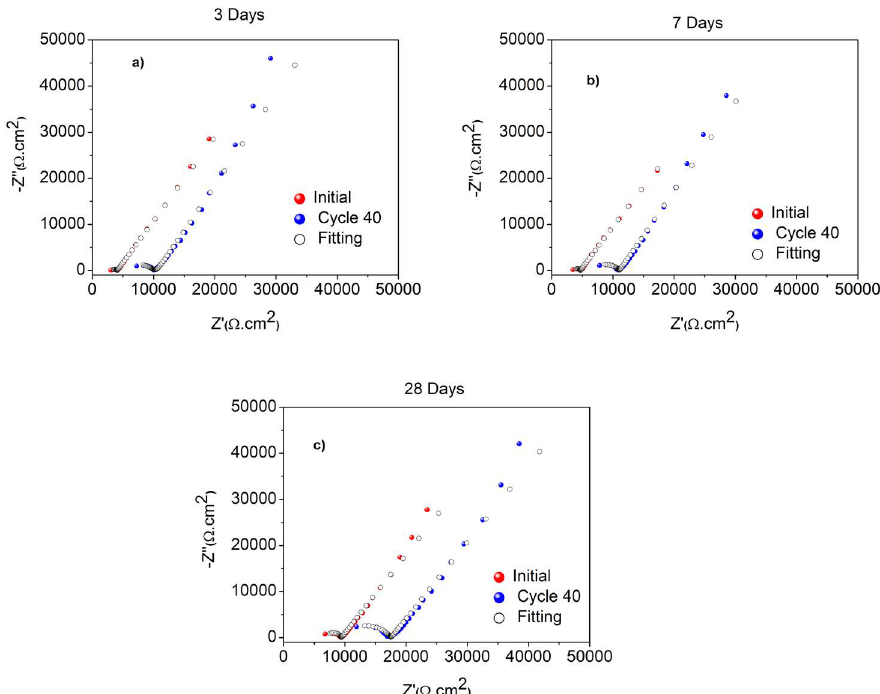
Figure 7. Electrochemical impedance curves - Nyquist Diagram – Fitting, (a) 3 days, (b) 7 days and (c) 28 days curing.